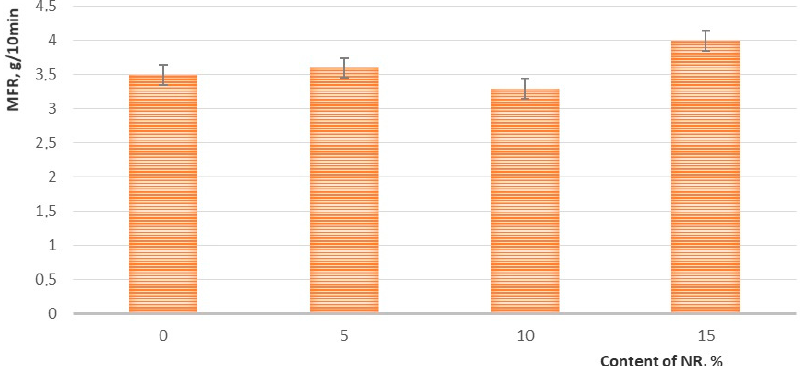
Figure 2. Melt flow rate of samples of nonwoven PLA/NR fiber containing 0, 5, 10, and 15 wt.% of NR.